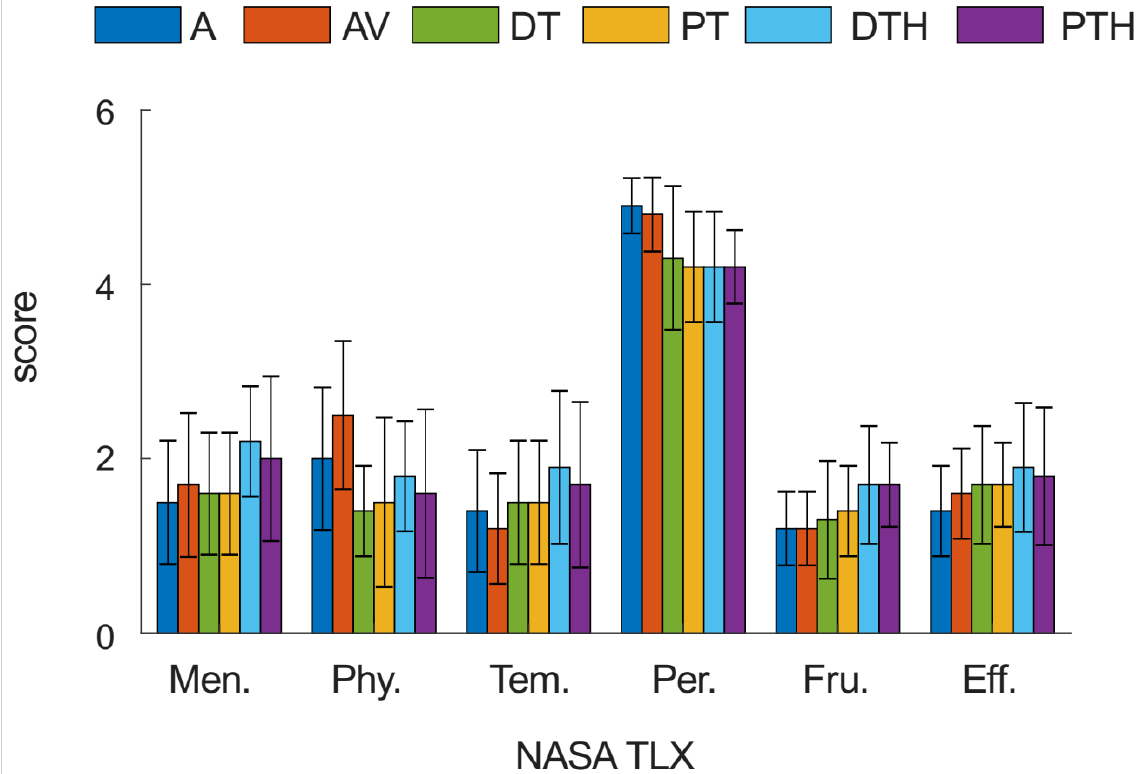
Figure 4. NASA task load index score (Men.: Mental demand; Phy.: Physical demand; Tem.: Temporal demand; Per.: Overall performance; Fru.: Frustration level; Eff.: Effort) for the unidirectional reaching task performed by healthy volunteers using all tested control modes. A: Active mode; AV: Active with viscous resistance mode; DT: Discrete tongue mode; PT: Proportional tongue mode; DTH: Discrete tongue hybrid mode; and PTH: Proportional tongue hybrid mode. The values are mean ± S.D. calculated across 10 healthy